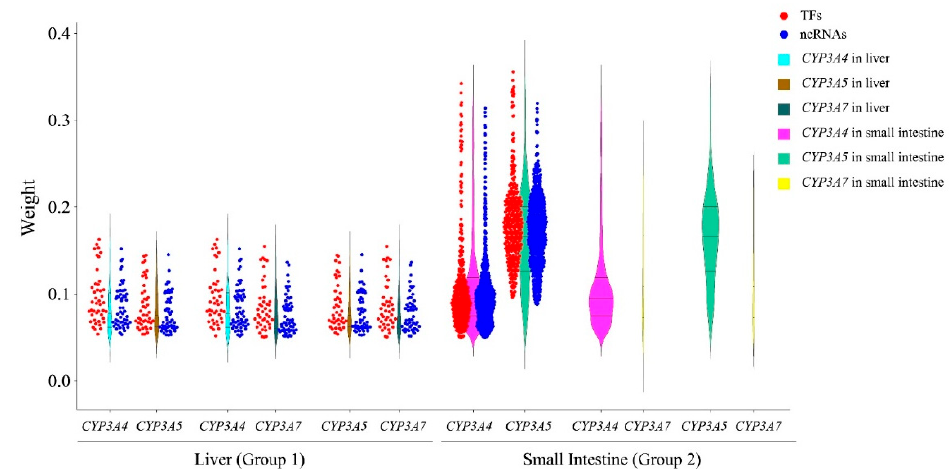
Figure 5. Comparison of CYP3A -associated TFs and ncRNAs with three CYP3As in the liver and small intestine. The y-axis is for the weight values calculated by WGCNA. Red and blue dots, respectively, represent the overlapping TFs and ncRNAs associated with two different CYP3As in the liver or small intestine. The violin plots with same color represent the same CYP3A in the same tissue.